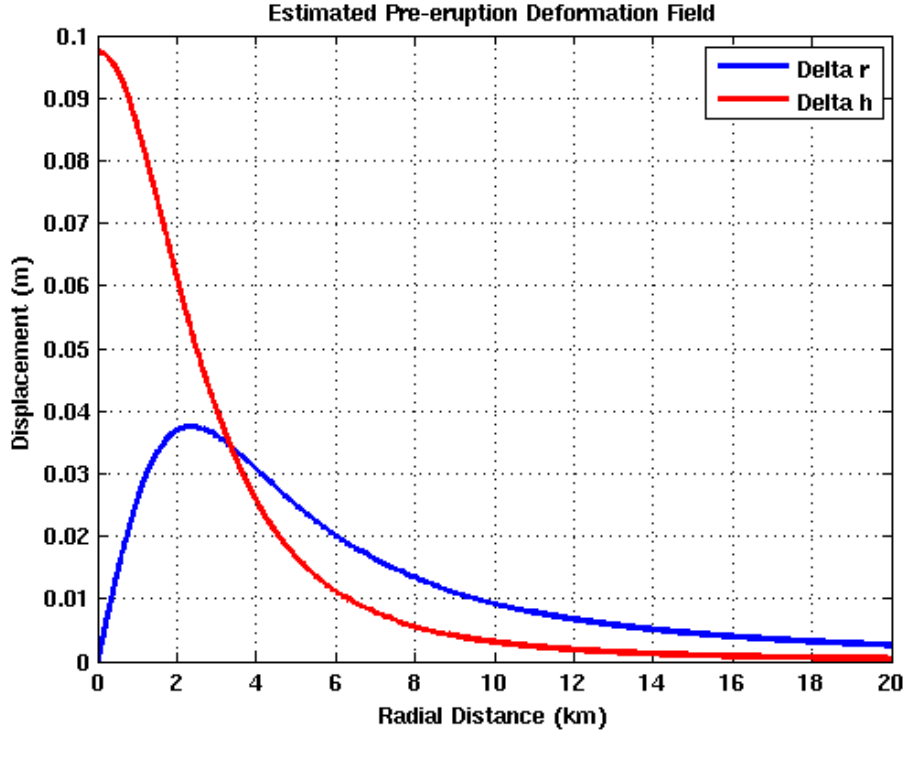
Figure 11. Modeled deformation field preceding the 2011 Grimsv ¨ otn